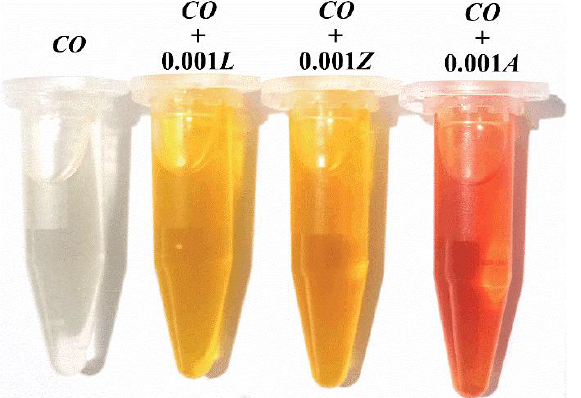
Figure 1. CO with a concentration of 0.001 molar of xanthophylls as additives: lutein (L), zeaxanthin (Z), and astaxanthin (A).